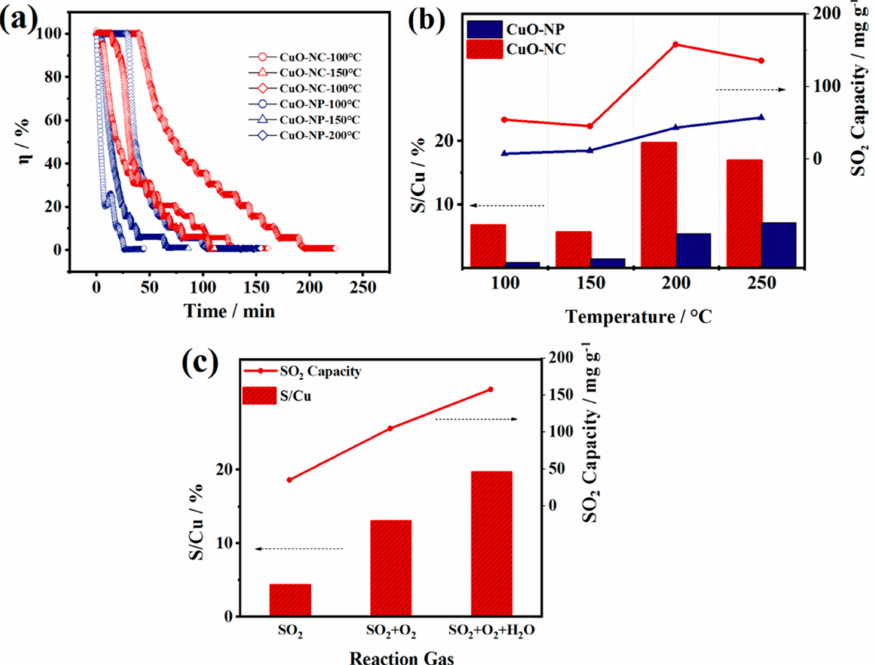
Figure 7. FGD test results of nano − CuOs. ( a ) Adsorption isotherms of SO 2 in CuO − NC and CuO − NP at different temperatures. ( b ) The influence of reaction temperature on the SO 2 removal performance of CuO − NC and CuO − NP. (The Efficiency threshold was defined as 50%) ( c ) The influence of reaction atmosphere on the SO 2 removal performance of CuO − NC. (GHSV = 8900 h − 1 , C SO = 2000 2